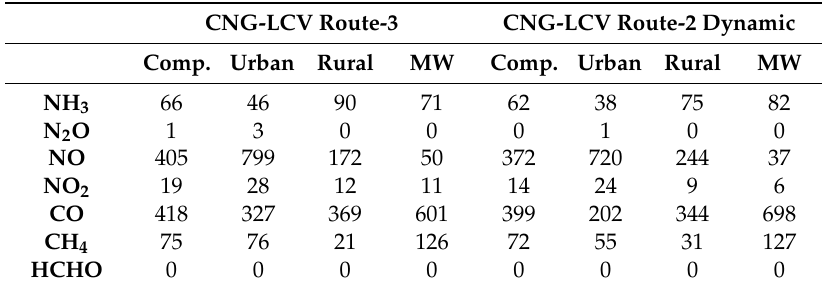
Table 5. NH 3 , N 2 O, NO, NO 2 , CO, CH 4 , and HCHO emissions factors (mg / km) obtained for the CNG-LCV during the two tests performed for each vehicle along Route-3 and Route-2. The vehicle was tested through dynamic driving on Route-2. Emission factors (mg / km) are presented for the complete routes (Comp.), as well as the urban, rural and motorway (MW) sections. CNG-LCV